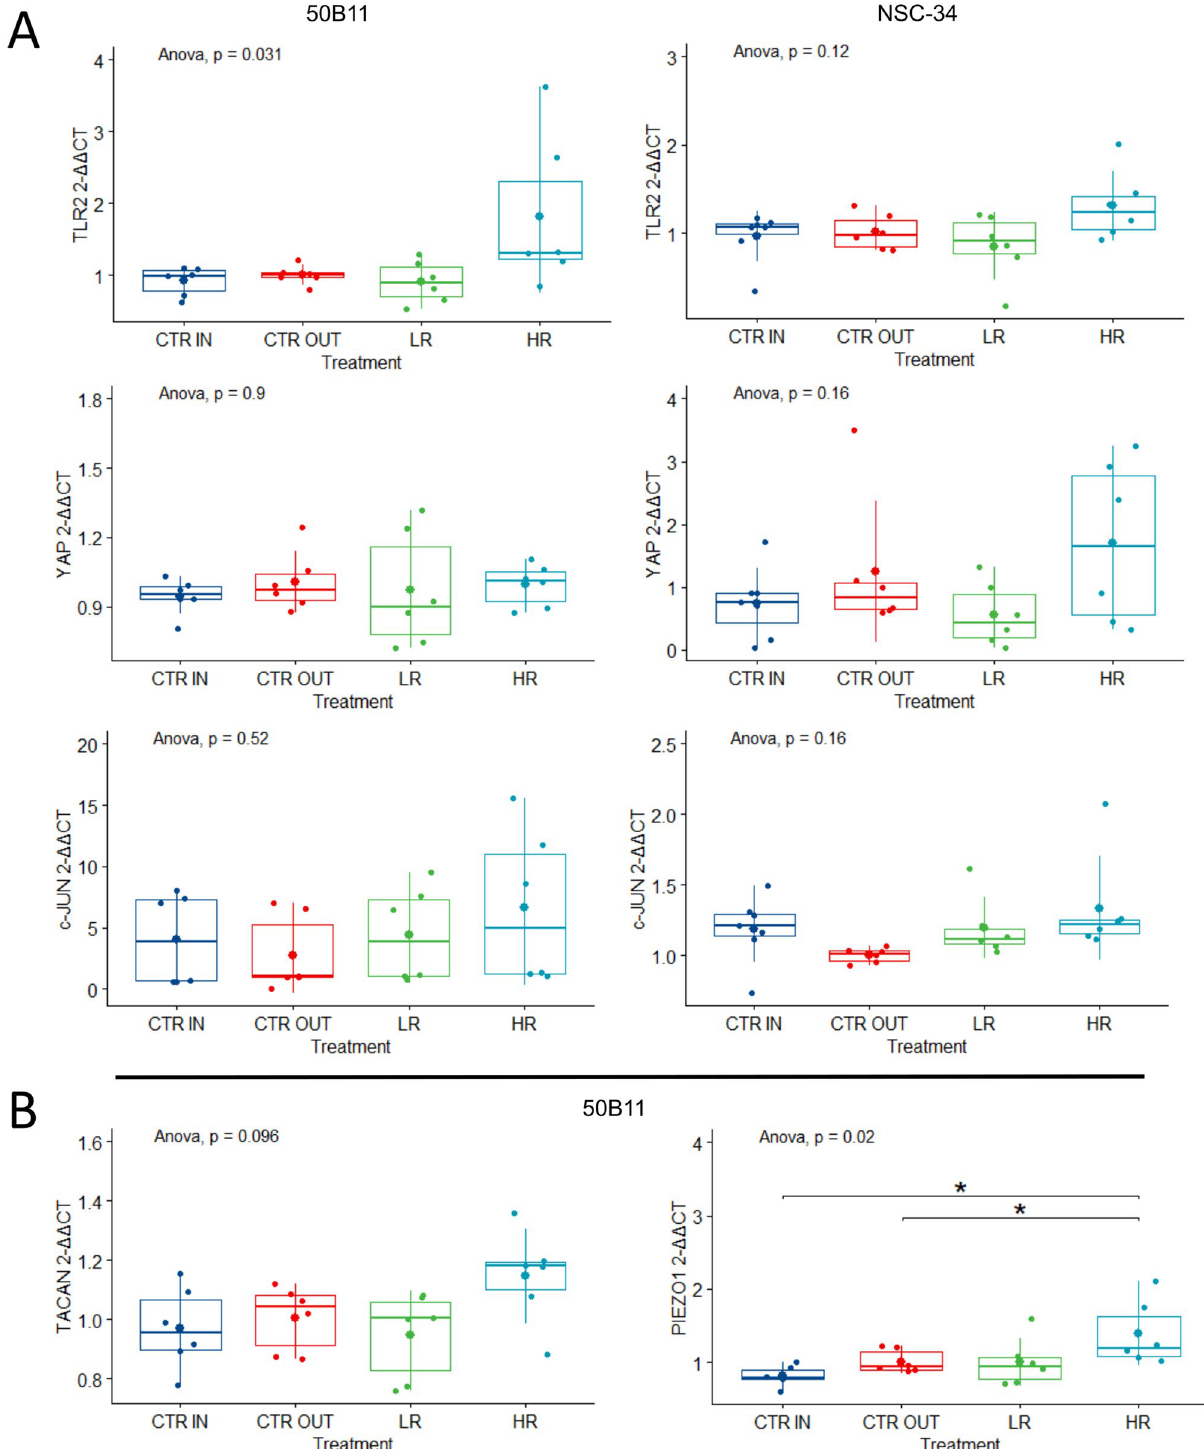
Figure 3. Quantitative gene expression analysis of mechanical allodynia and neuropathic pain markers. Relative quantification (2 −ΔΔCt ) of genes was evaluated by qRT-PCR to assess benefits or side effects induced by neurodynamic protocols on sensory and motor neurons. TATA-binding protein (TBP) was used as a housekeeping gene to normalize data. All data were calibrated to CTR OUT samples. Values in the graphics are expressed as mean ± SD. One-way ANOVA was carried out (data are normally distributed with comparable variances). ( A ) Expression of TLR2, YAP, and c-JUN is reported to assess the effects of NDT on mechanical allodynia and neuropathic pain. No statistically significant differences with CTR OUT were observed. ( B ) Expression of TACAN and PIEZO1 is reported to assess the effects of NDT on mechanical hyperalgesia and mechanical anti-nociception in sensory neurons 50B11; asterisks show statistically significant differences (* p ≤